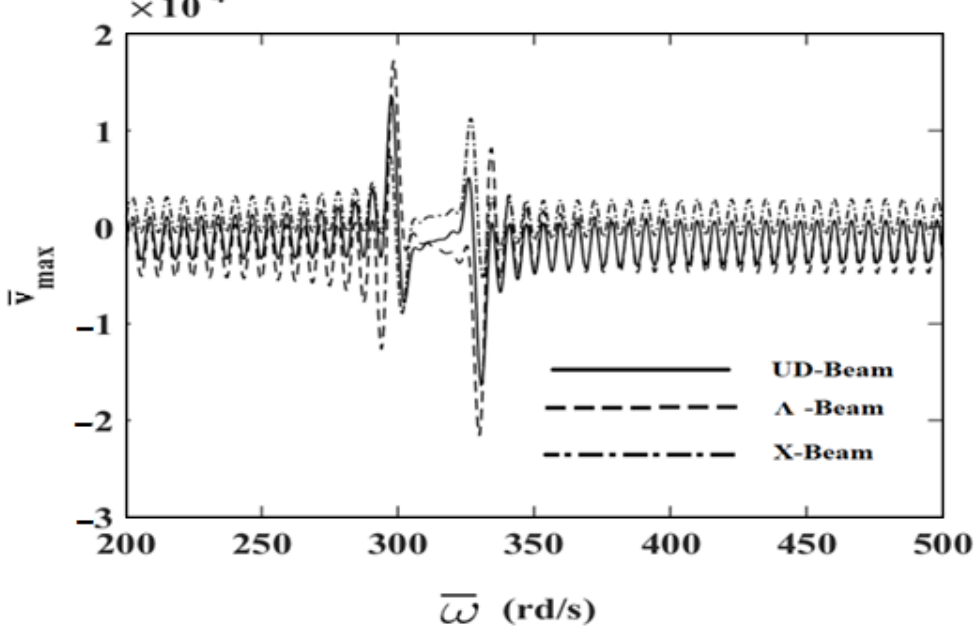
Figure 7. The relationship between the displacements and the frequency of the dynamic load ( 𝑤̅ ) for V CNT = 0.28.